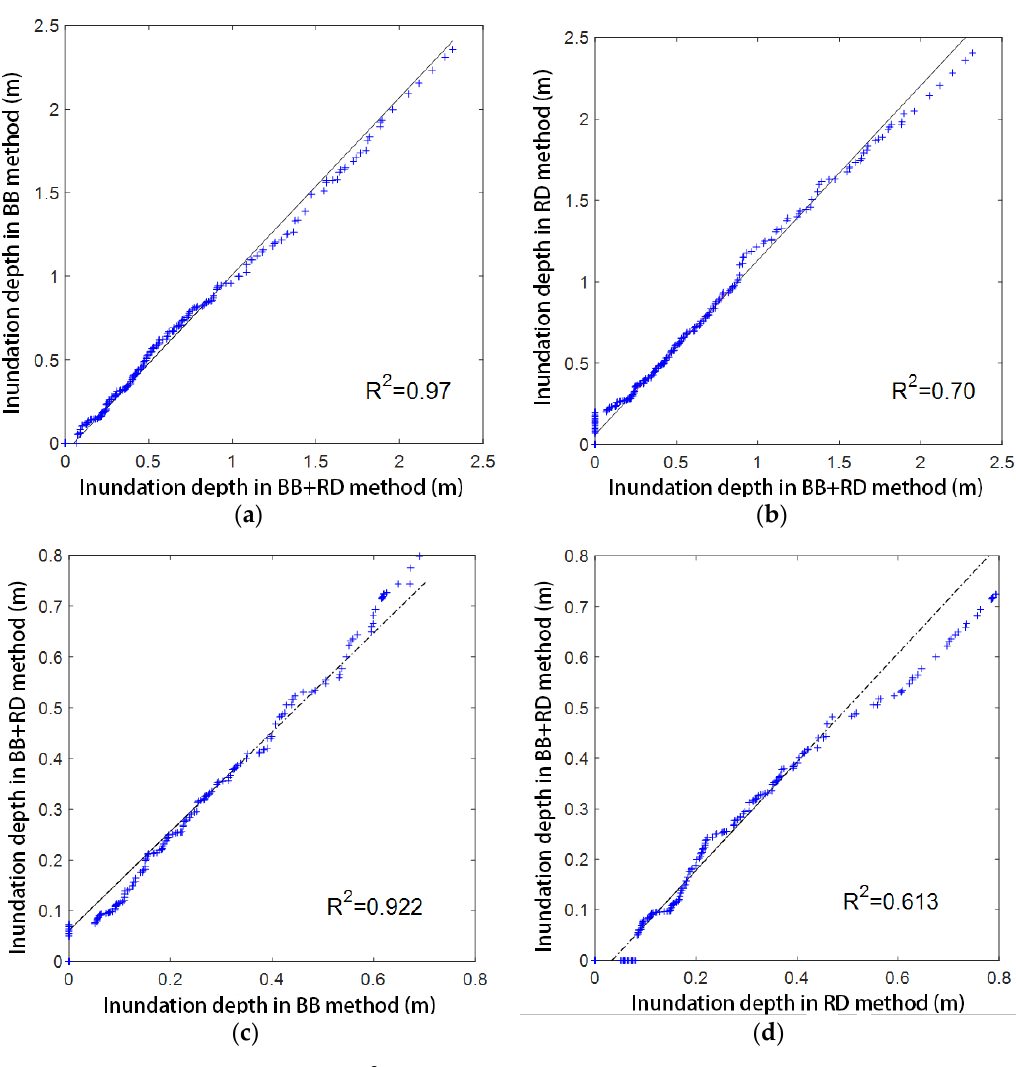
Figure 13. Correlation coefficients ( R 2 ) for maximum inundation depth: ( a ) cases C1 and C8; ( b ) cases C1 and C7; ( c ) cases C2 and C10; ( d ) cases C2 and C9.